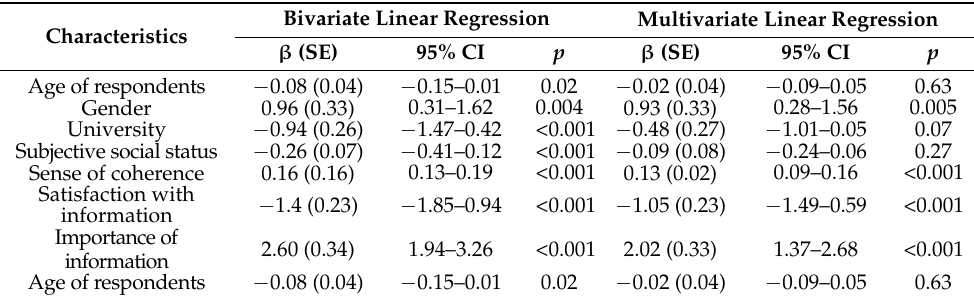
Table 8. Bivariate and multivariate linear regression of sociodemographic and further characteristics with overall digital health literacy ( n =